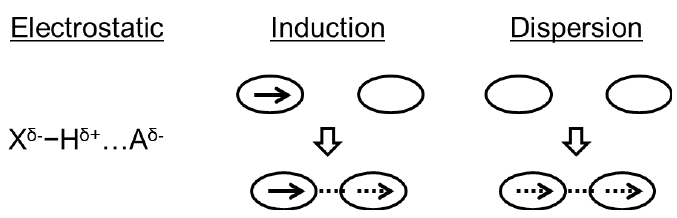
Figure 3. Three kinds of interactions in hydrogen